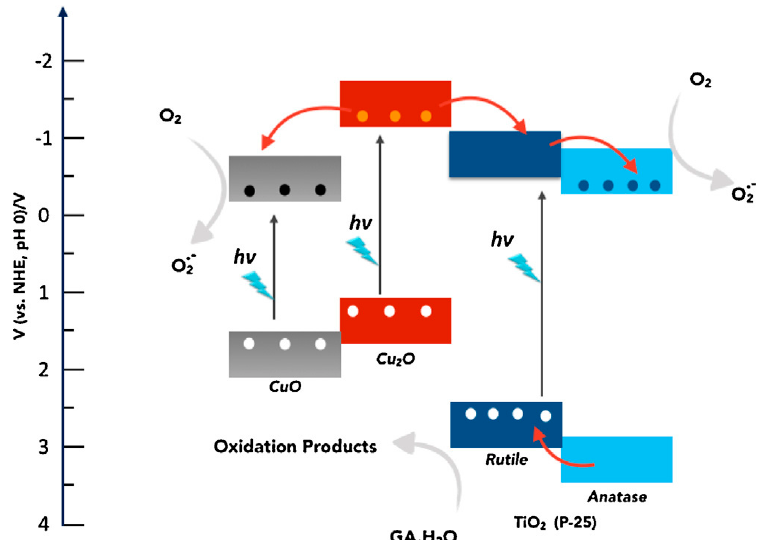
Figure 18. A proposed scheme showing the photoredox processes during degradation of gallic acid (GA) in presence of Cu 2 O–CuO–TiO 2 (P25) photocatalysts, air and visible light (LEDs). Reprinted with permission from [109]. Copyright Elsevier,